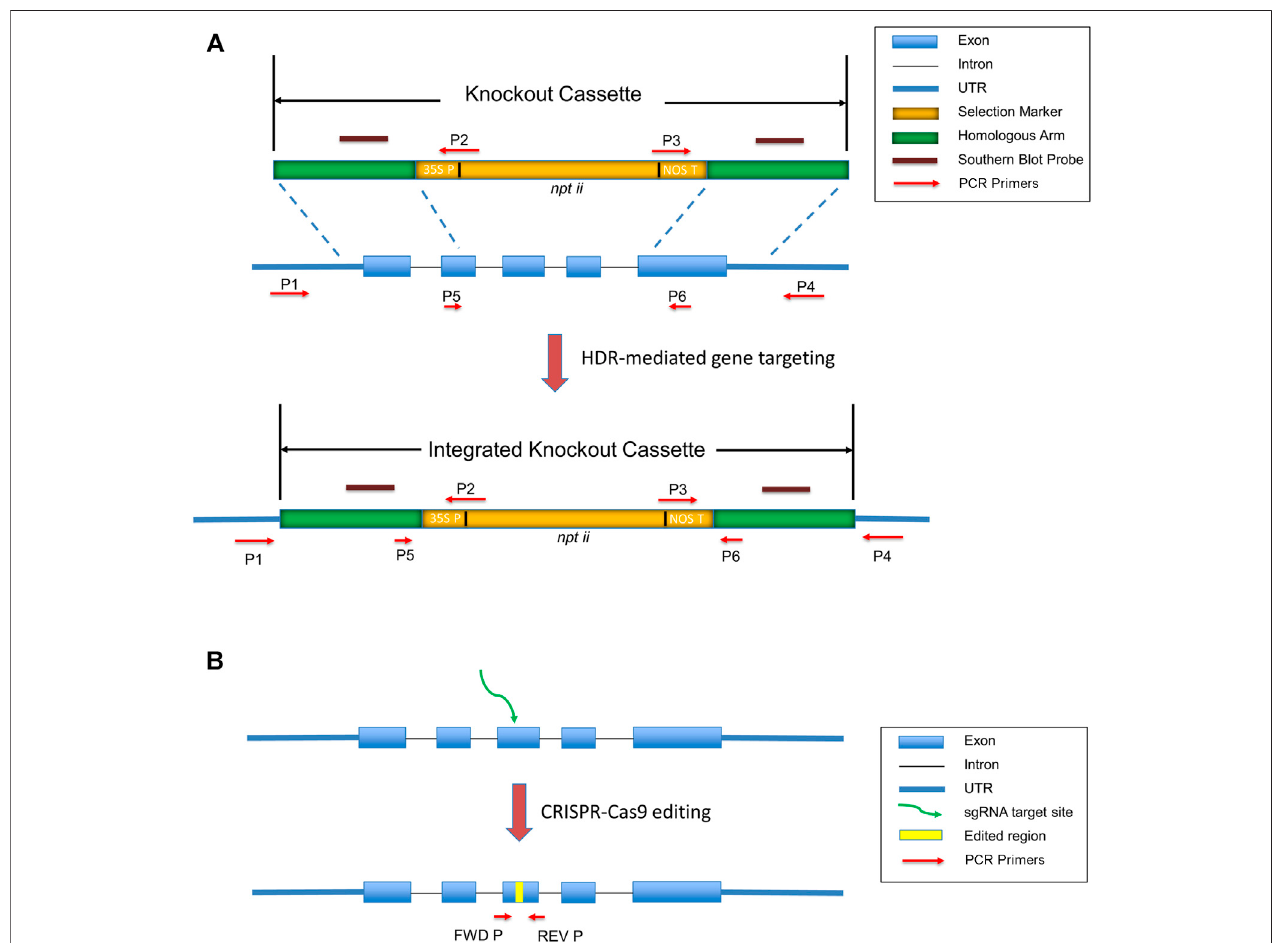
FIGURE1| Targeted geneknockoutgenerated bygene targeting and CRISPR-Cas9. (A) Asuccessful genetargeting event results intargeted gene replacement. The knockout cassette contains homologous arms fl anking npt ii genes driven by 35S promoter and tailed with a nos terminator. By transformation of a linearized knockout cassette to the moss protoplasts, the marker gene nptii is integrated into the genome, resulting in targeted gene replacement. (B) A frameshift mutant generated by CRISPR-Cas9. The yellow bar indicates gene-edited sequences. The green arrow suggests the target site. Red arrows show the location of primers (FWD P and REV P) for the ampli fi cation of the edited